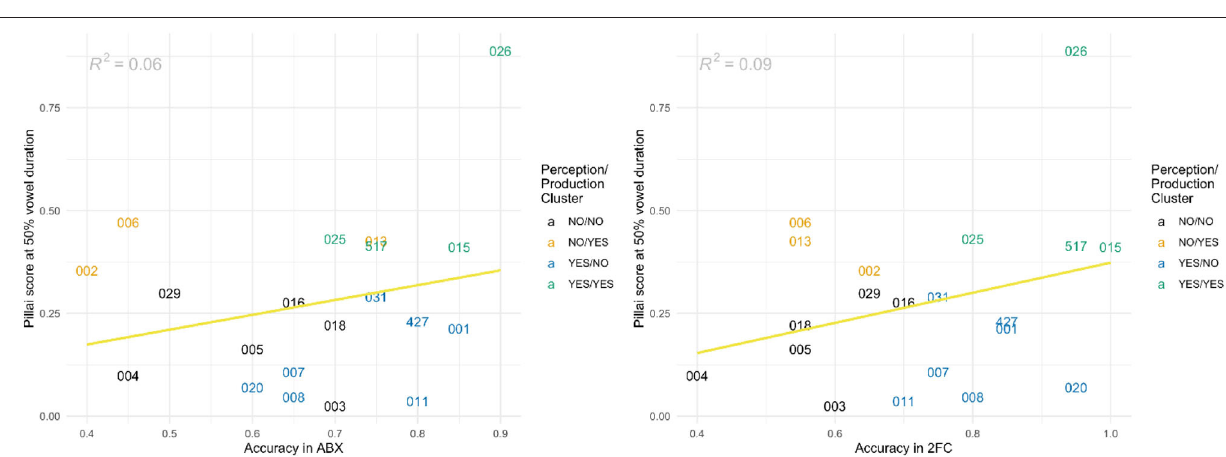
FIGURE 5 | Correlations between Pillai scores at 50% vowel duration and ABX perception accuracy (left) or 2FC perception accuracy (right) for cot-caught. Participants are clustered based on perception and production independently, with the two clustering analyses visually combined to show 4 groups, where the first NO or YES of each label signifies the contrast in perception and the second NO or YES signifies a contrast in production. NO/NO (participant clustered in the group with no contrast based on Pillai scores for both production and perception) is shown in black. NO/YES (participant in no-contrast group in perception, but in contrast group in production) is in orange. YES/NO (participant in contrast group in perception, but in no-contrast group in production) is in blue and YES/YES (contrast in both production and perception) is in green. been also reported before syllabic /r/, as in fire [f 2 i Ä ]; but in tap, contrary to what would be expected from the spelling. This shows a tendency for this diphthong to spread outside the context where it emerged (cf. also tiger, fire , without a following coronal stop, etc.). In our stimuli the diphthong is always followed by a morpheme-final coronal stop.